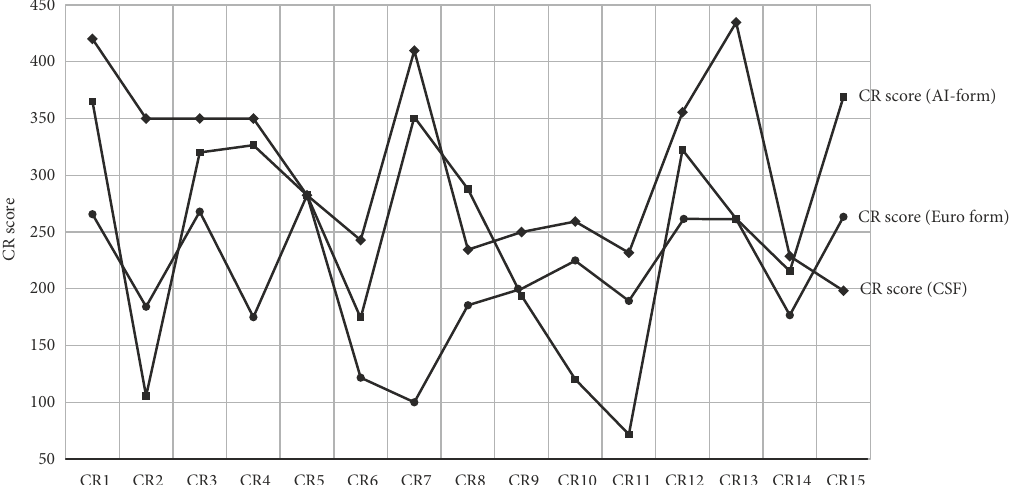
Figure 14. CR satisfaction score for CSF, Al-form and Euro